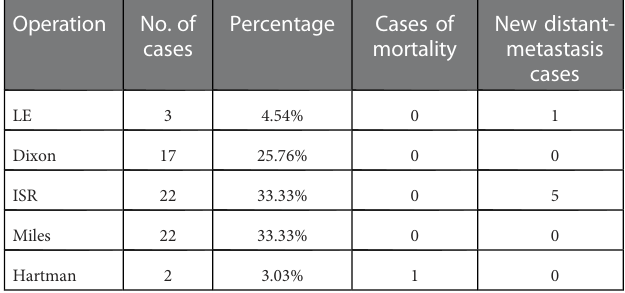
TABLE 2 Follow-up treatment plan for non-CR